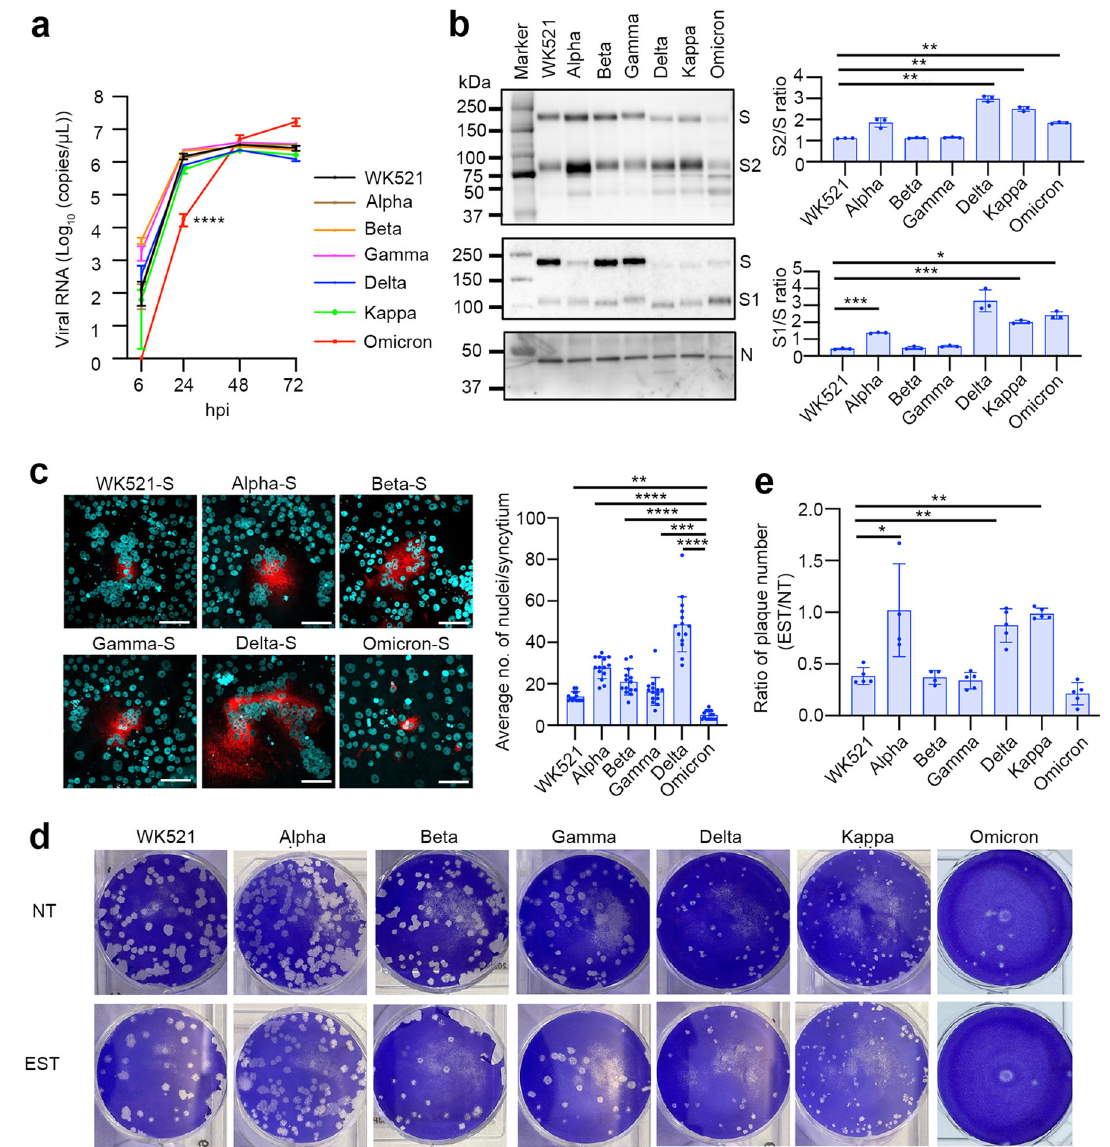
Fig. 1 | The replication ability, spike protein cleavage, fusion capability and entryphenotypeofSARS-CoV-2inVeroE6/TMPRSS2cells.a Replicationkinetics incellsinfectedwithvirusesatanMOIof0.1.ViralRNAcopynumbersintheculture supernatants were quanti fi ed at 6, 24, 48 and 72h post-infection (p.i.). Error bars indicate the standard deviations (SD) of triplicate wells. Mean values±SD are shown, and signi fi cant differences were determined with one-wayANOVA. Multiple comparisonsbetweenWK521andothervariantswereadjustedwithDunn ’ smultiple comparisonstest,**** P <0.0001at24hpi(vsOmicron). b SandNproteinsdetected intheculturesupernatantofinfectedcells.SDS-PAGEandwesternblotanalysis(left panel). Quanti fi ed S protein cleavage rate (bar graphs in the right panels). Data are representative of triplicate independent experiments. Mean values±SD are shown, andstatisticalsigni fi cancewasdeterminedwithBrown – ForsytheandWelchANOVA tests. Multiple comparisons between WK521 and other variants were adjusted with Dunnet ’ s T3 multiple comparisons test, in S2 ** P =0.0050 (vs Delta), ** P =0.0064 (vs Kappa), ** P =0.0037 (vs Omicron) and in S1 *** P =0.0002 (vs Alpha), *** P =0.0005 (vs Kappa) and * P =0.0116 (vs Omicron). c Syncytium formation in cells transfected with the S protein expression plasmid. S protein was detected by